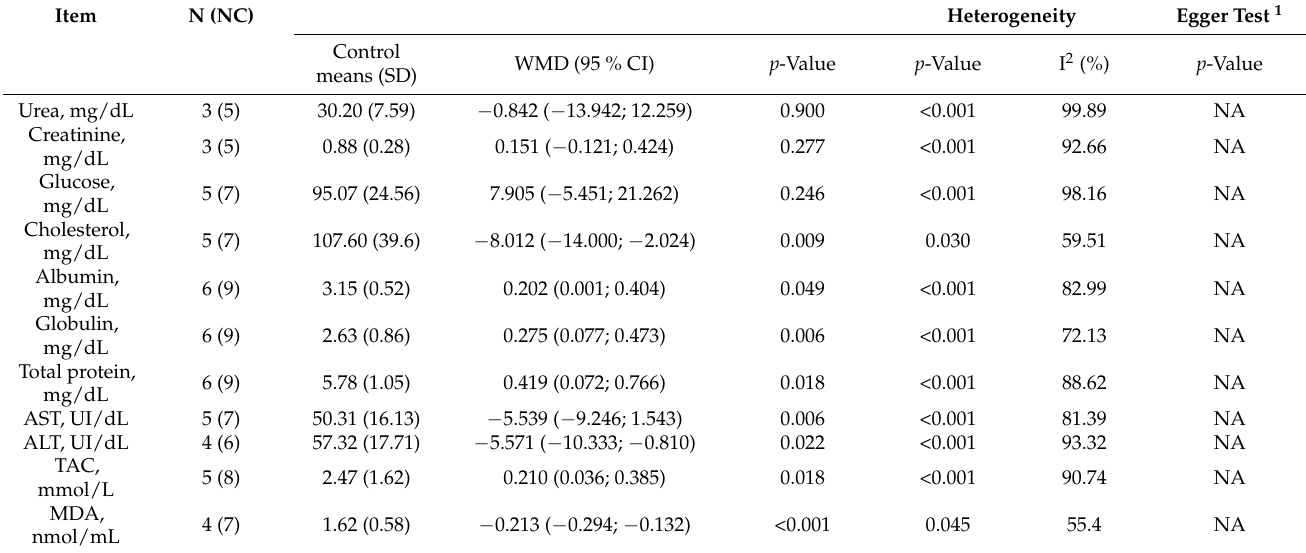
Table 5. Serum metabolites of rabbits supplemented with